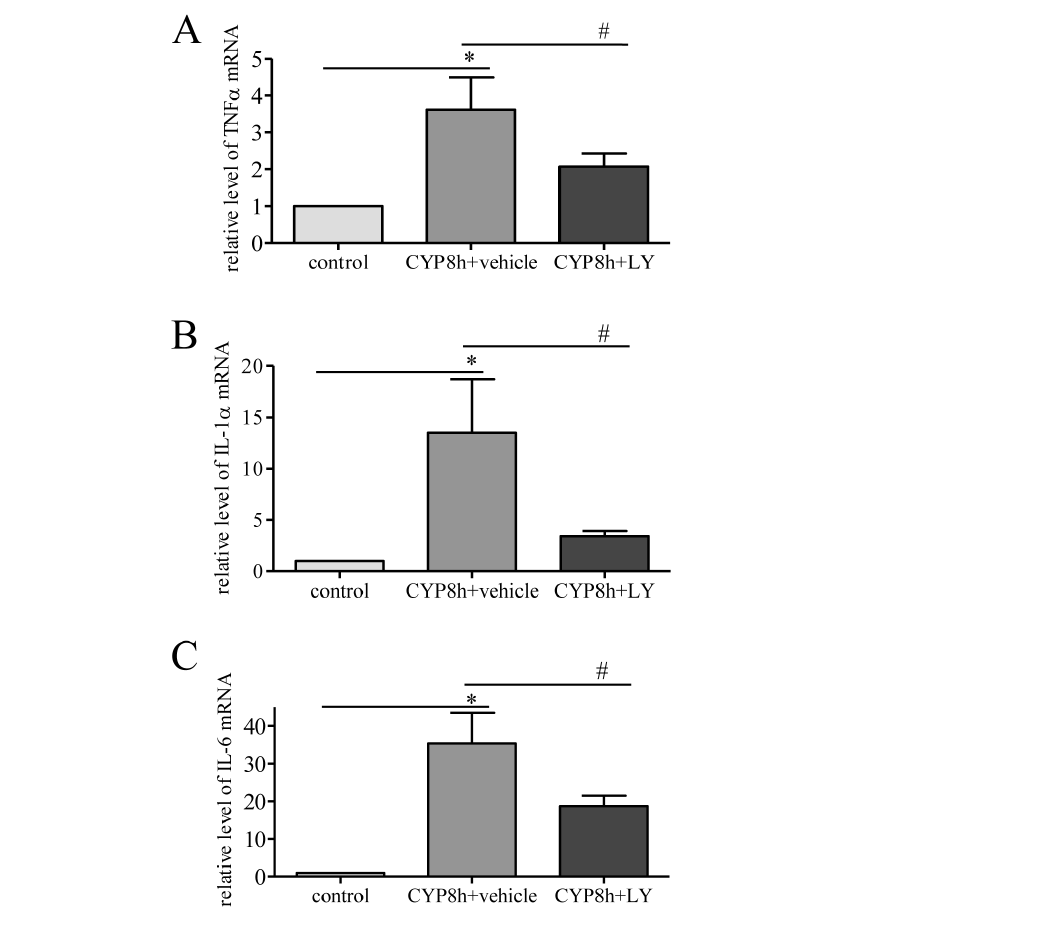
Fig. 5. Cystitis-induced up-regulation of pro-inflammatory factors was attenuated by LY294002 treatment. The levels of tumor necrosis factor alpha (TNF a ) (A), interleukin 1 a (B) and IL-6 (C) were up- regulated by cystitis examined at 8 h post CYP injection. LY294002 (LY) treatment reversed inflammatory responses in the urinary bladder caused by cystitis. n 5 3. *, p , 0.05 vs vehicle control. # , p , 0.05 vs CYP